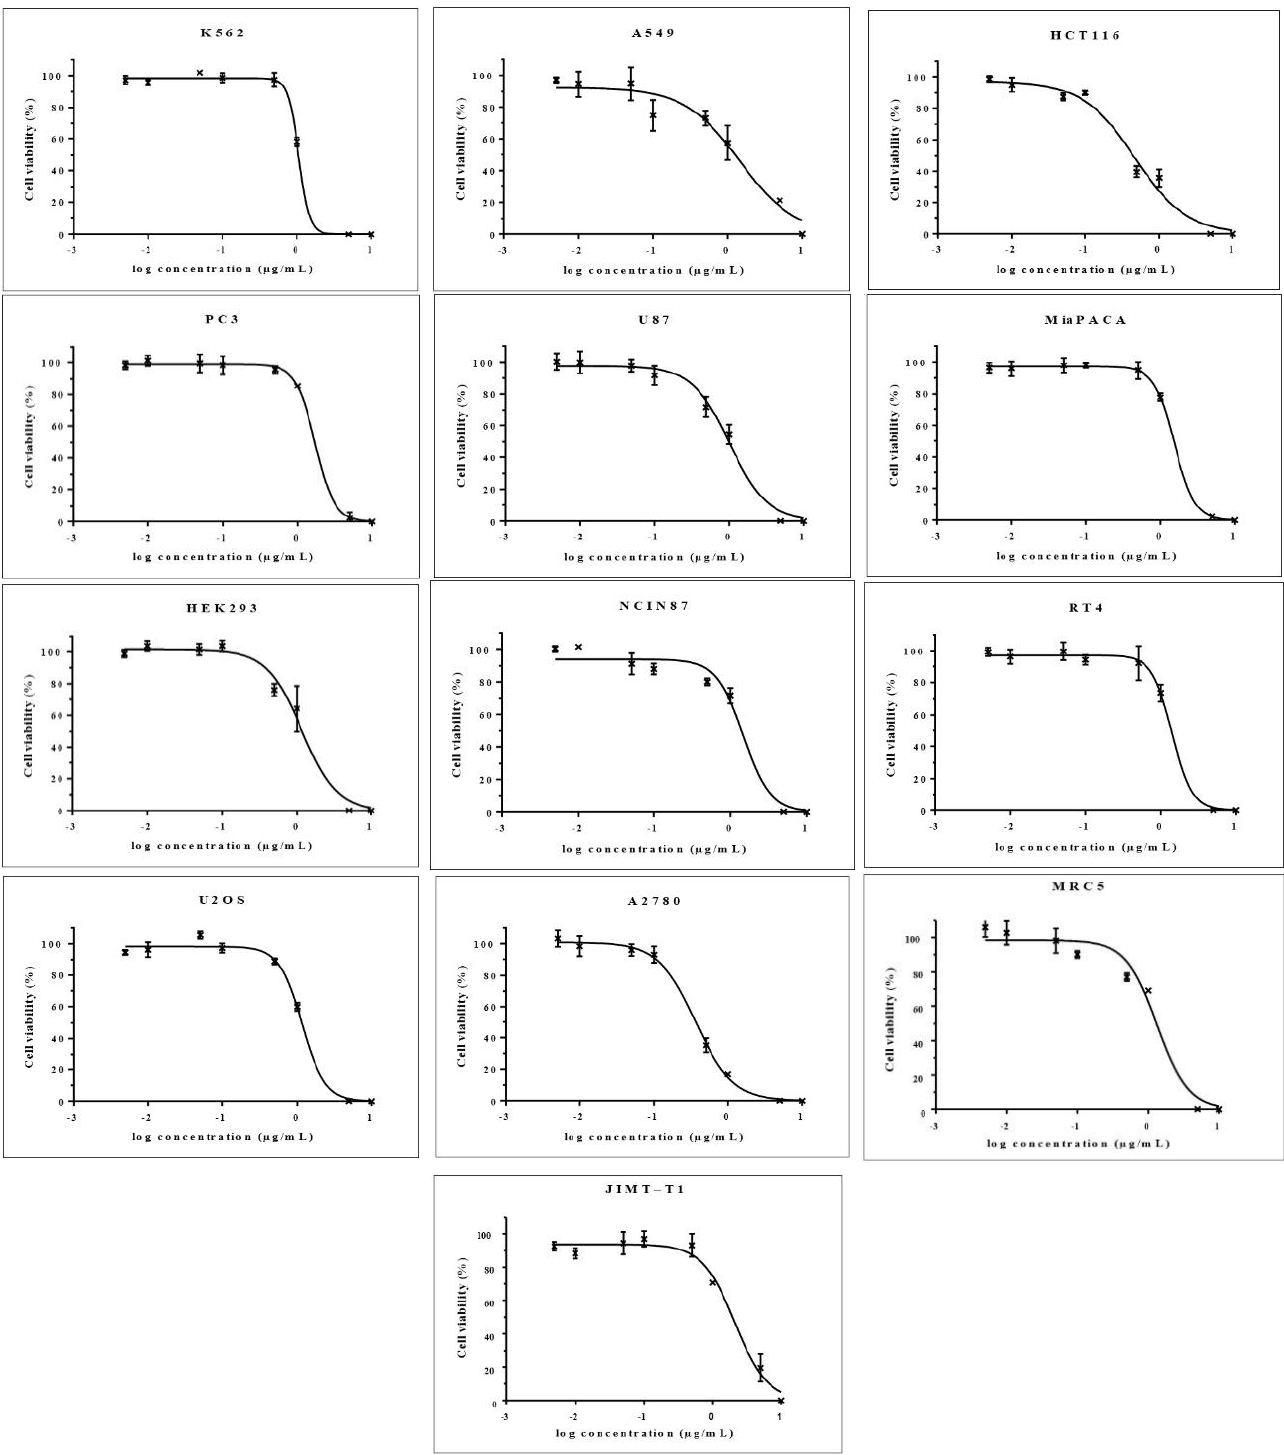
Figure 1. C ytotoxicity curves of the essential oil of Tagetes minuta L. Figure 1. Cytotoxicity curves of the essential oil of Tagetes minuta